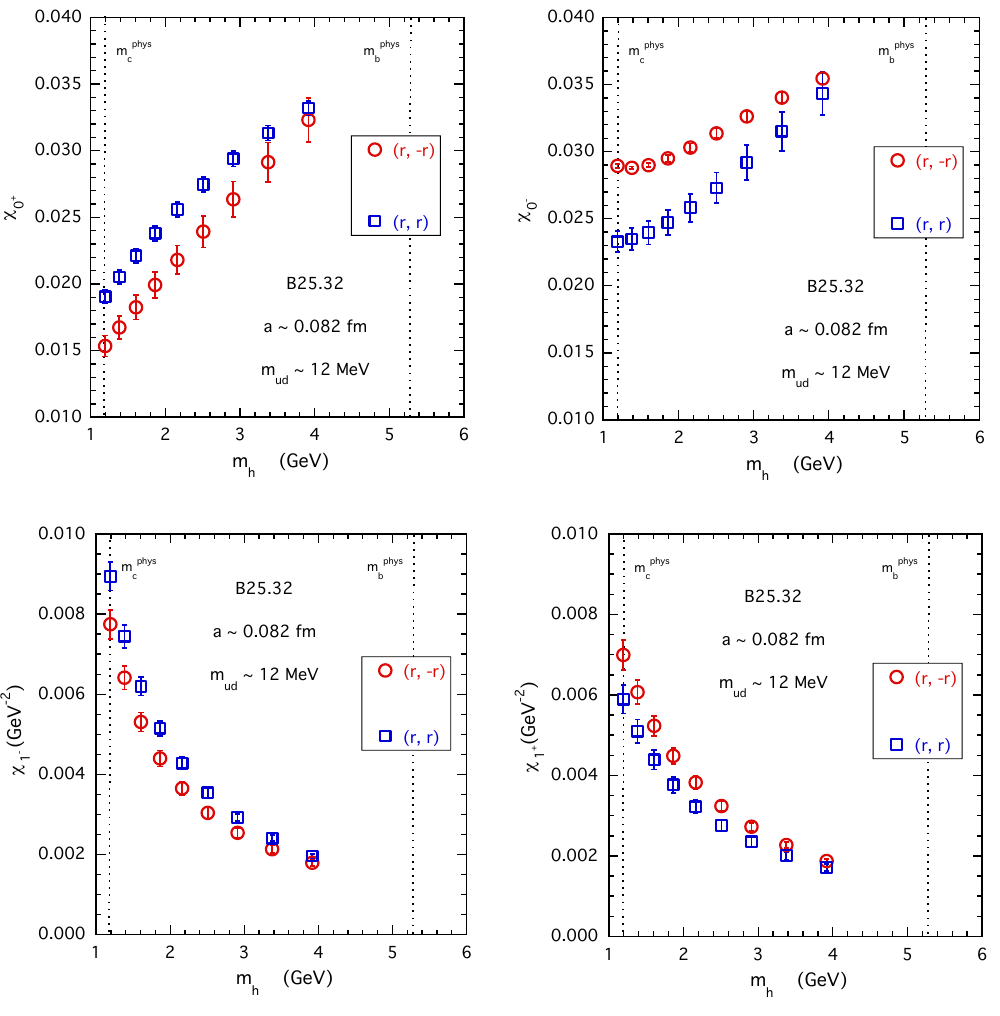
(left top panel), χ (right top panel), χ (left bottom panel) Figure 5 . The susceptibilities χ 0 + 0 − 1 − and χ (right bottom panel) corresponding to the gauge ensemble B25.32 for the h → u transitions 1 + as a function of the heavy-quark mass m given by eq. (A.19) up to n = 9 , i.e. up to m (9) ’ 3 . 9 GeV. h h The red circles correspond to the choice of opposite values ( r, − r ) of the two valence-quark Wilson parameters, while the blue squares refer to the case of equal values ( r, r )